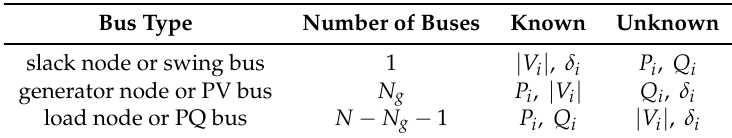
Table 1. Network bus type. i : index of the bus; N g : number of generator buses; N : total number of buses in the